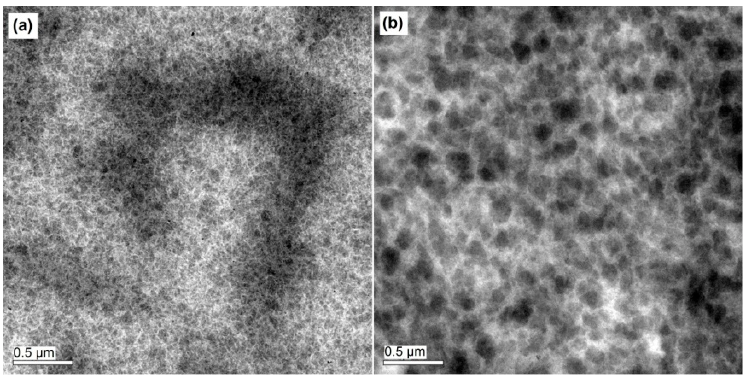
Figure 7. TEM images of PBDTS-ID:PC 71 BM ( a ) and PBDTS-DTNT:PC 71 BM ( b ) blend films with 3% DIO additive treatment.